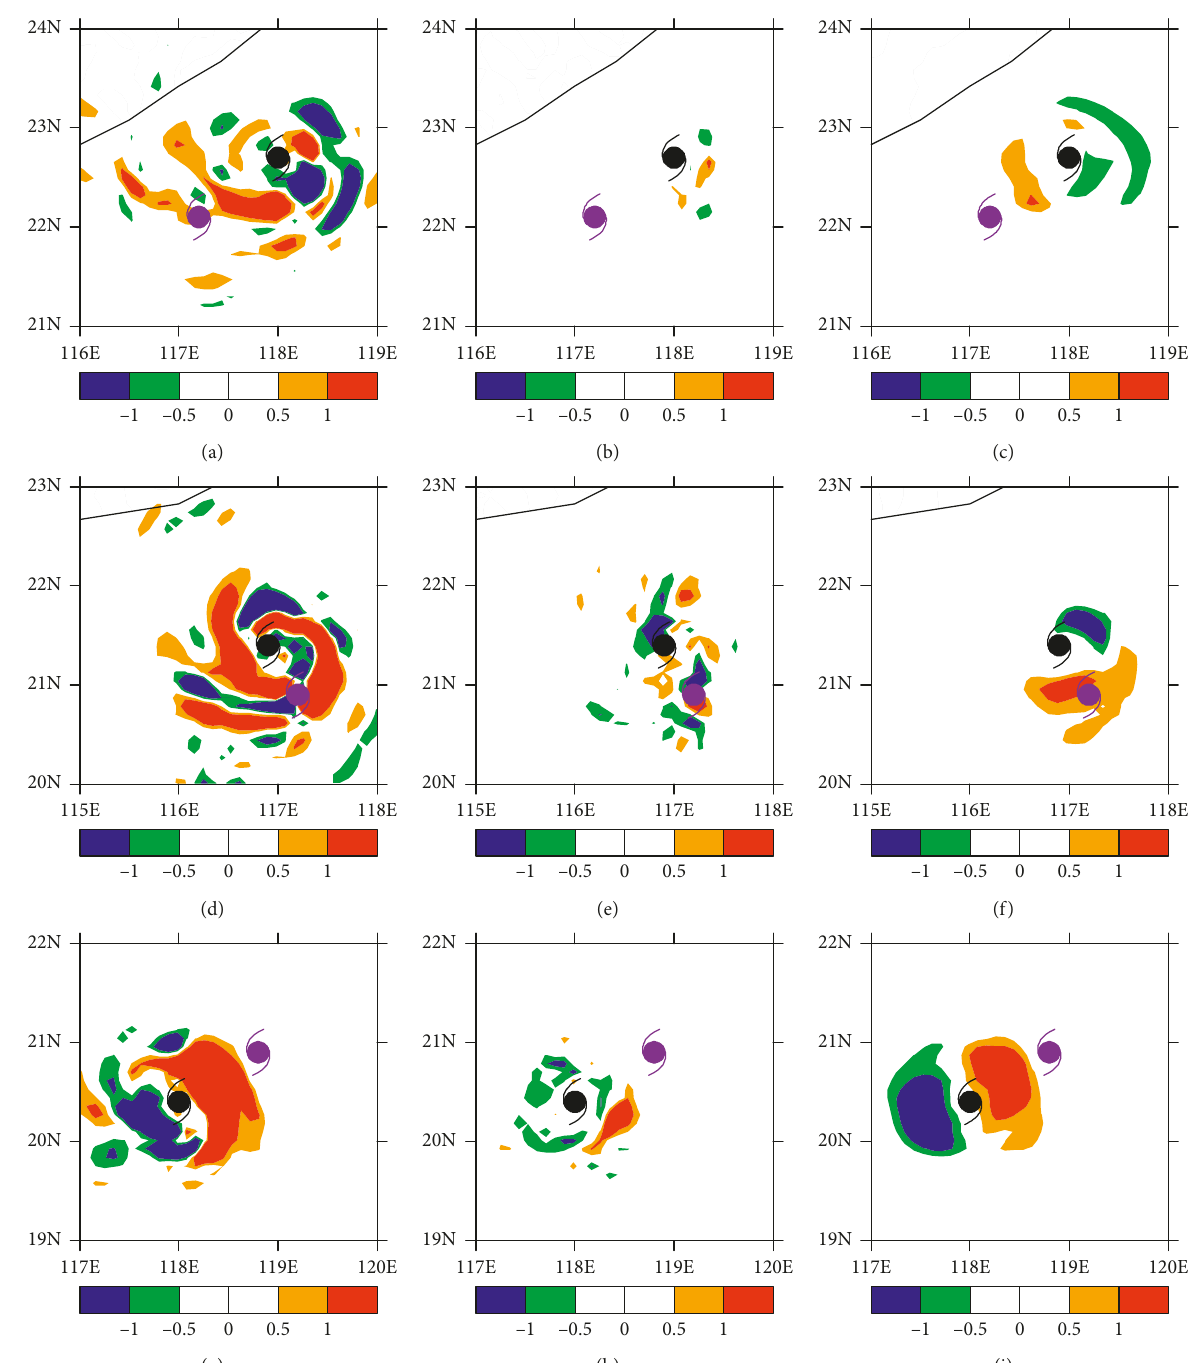
Figure 8: Vertical integrals of horizontal PV advection (HA (a, d, g)), diabatic heating (DH (b, e, h)), and PV tendency (PVT (c, f, i)) in the CTL experiment at 0600 UTC 25 August (a–c), 0000 UTC 26 August (d–f), and 1800 UTC 26 August (g–i). Black dot represents the current Tembin’s position and purple dot represents the next 6h Tembin’s position (unit: 10 − 6 K m 2 kg − 1 s − 2